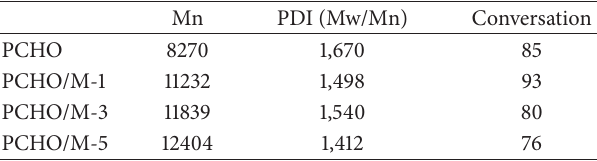
Table 2: GPC data of pure polymer and